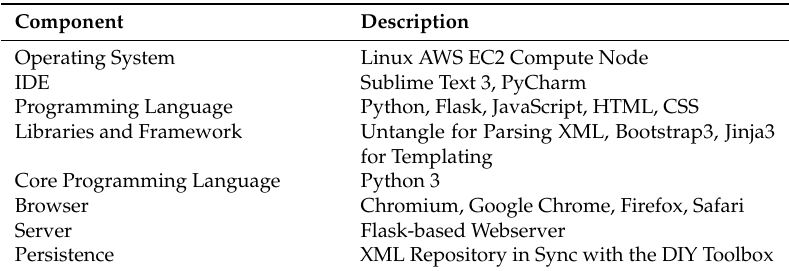
Table 2. Technology stack of the cloud-based web